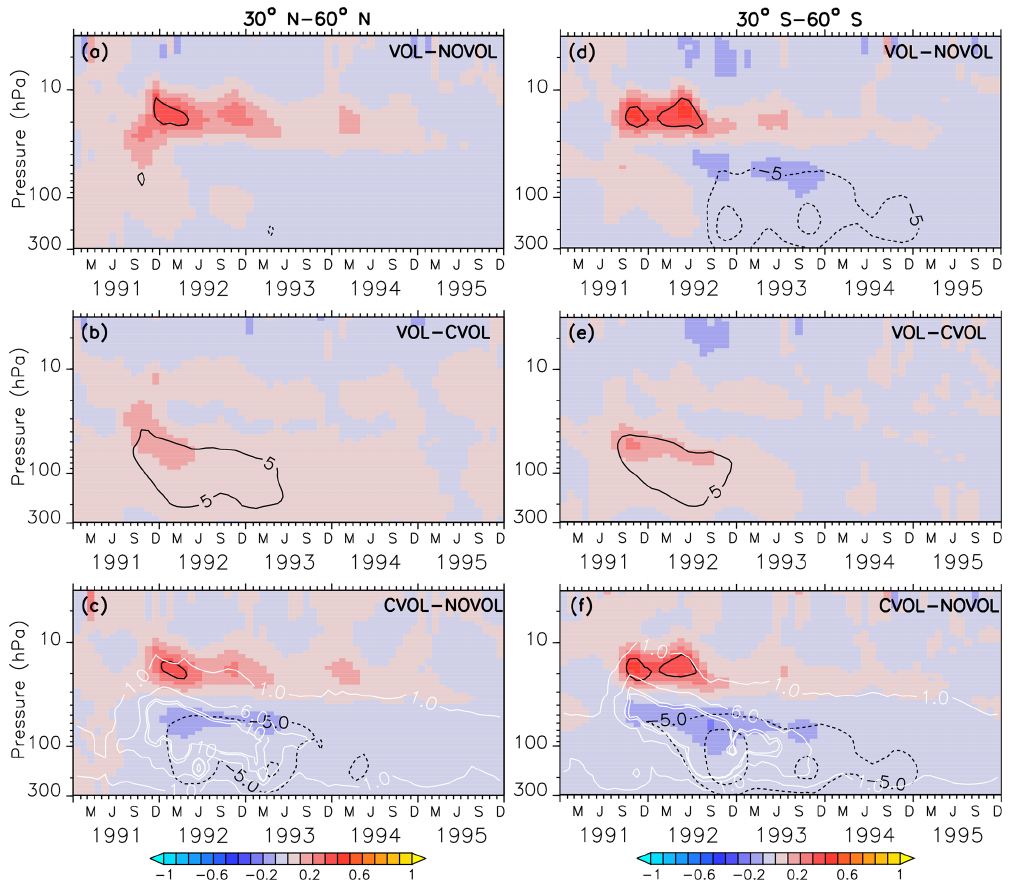
Figure 8. Zonally averaged differences in ozone mixing ratios (ppmv) between the simulations VOL − NOVOL (a, d) , VOL − CVOL (b, e) , and CVOL − NOVOL (c, f) . Contours indicate the corresponding relative changes (%). Shown are averages over the midlatitudes 30– 60 ◦ N (a, b, c) and 30–60 ◦ S (d, e, f) . Contour intervals are 5%. White contours in (c) and (f) show the liquid aerosol surface area density (10 − 8 cm 2 cm − 3 ) in VOL and CVOL with intervals of 1, 5, and